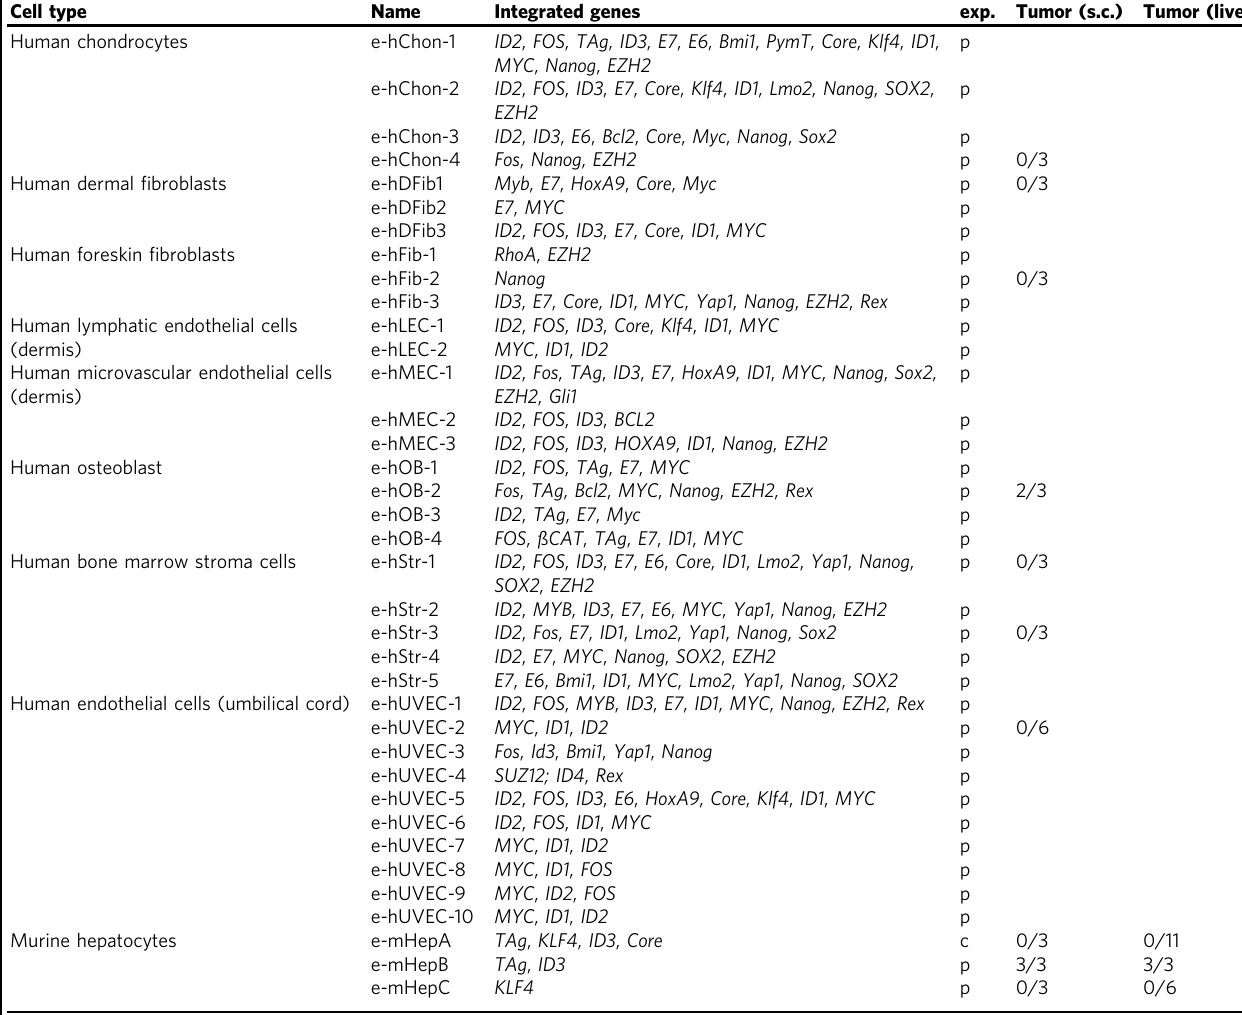
Table 1 Overview of cell types immortalized in this study Cell type